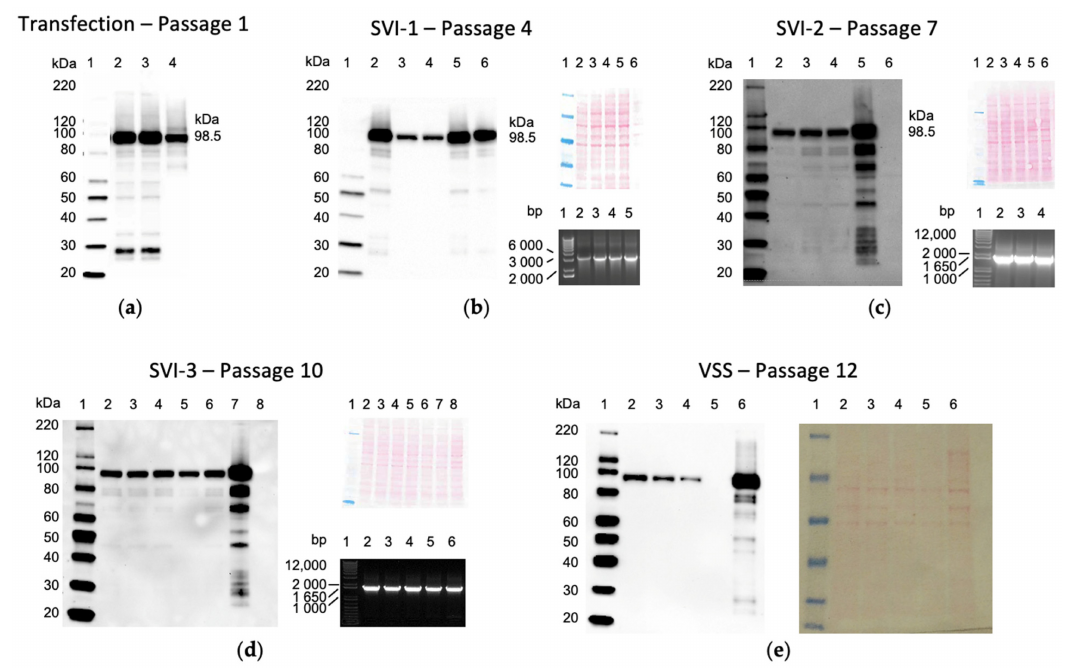
Figure 2. Control of critical steps and process intermediates. At critical stages of the clonal purification and expansion cycles, virus cultures were tested for tHIVconsv6 protein expression in infected HeLa cells using anti-HIV-1 Gag p24 mAbs (ab9071) specific for the C-terminal region 1 in a Western blot ( a – e ). The amount of loaded protein in each lane was visualized by direct protein staining ( b – e ). Transgene presence was assessed by flank-to-flank ( b ) and ID ( c , d ) PCRs (only one or the other is shown). ( a ) Passage-1 cells were transfected with BAC-excised linear ChAdOx1.tHIVconsv6 genomic DNA, the rescued virus was expanded by one passage and the transgene expression was confirmed. M r markers in kDa (lane 1); MOI 500 (lane 2); MOI 1000 (lane 3); and RG vaccine ChAdOx1.tHIVconsv6 was used as a positive control (lane 4). ( b ) Passage 4. Following SVI-1, tHIVconsv6 expression (left) and transgene presence (bottom right) were confirmed for clones 1AC8 (lane 2), 1BE4 (lane 3), 3BA5 (lane 4), 3BG1 (lane 5) and RG (lane 6). ( c ) Passage 7. SVI-2 yielded clones 1BE4.3AG3 (lane 2), 3BG1.1AC11 (lane 3) and 3BG1.1BE5 (lane 4), which were compared to the RG vaccine (lane 5) and uninfected HeLa cell lysate (lane 6) for HIVconsv6 expression (left) and transgene presence by ID PCR (bottom right). ( d ) Passage 10. Following SVI-3, the transgene product expression (left) and transgene presence (bottom right) were analysed for clones 3BG1.1A11.1AE1 (lane 2), 1BE4.3AG3.1CC4 (lane 3), 3BG1.1BE5.3AA5 (lane 4) and 1BE4.3AG3.1AD12 (lane 5). SVI-2 clone 3BG1.1BE5 (lane 6), the RG vaccine (lane 7) and uninfected Hela cells (lane 8) were used as controls. ( e ) Passage 12. The VSS was generated from 3BG1.1AC11.1AE1, and tHIVconsv6 expression (lane 2) was compared to SVI-3 clone 3BG1.1AC11.1AE1 (lane 3), SVI-2 clone 3BG1.1AC11 (lane 4), uninfected Hela cells (lane 5) and the RG vaccine (lane 6) (left), with the total loaded protein visualized